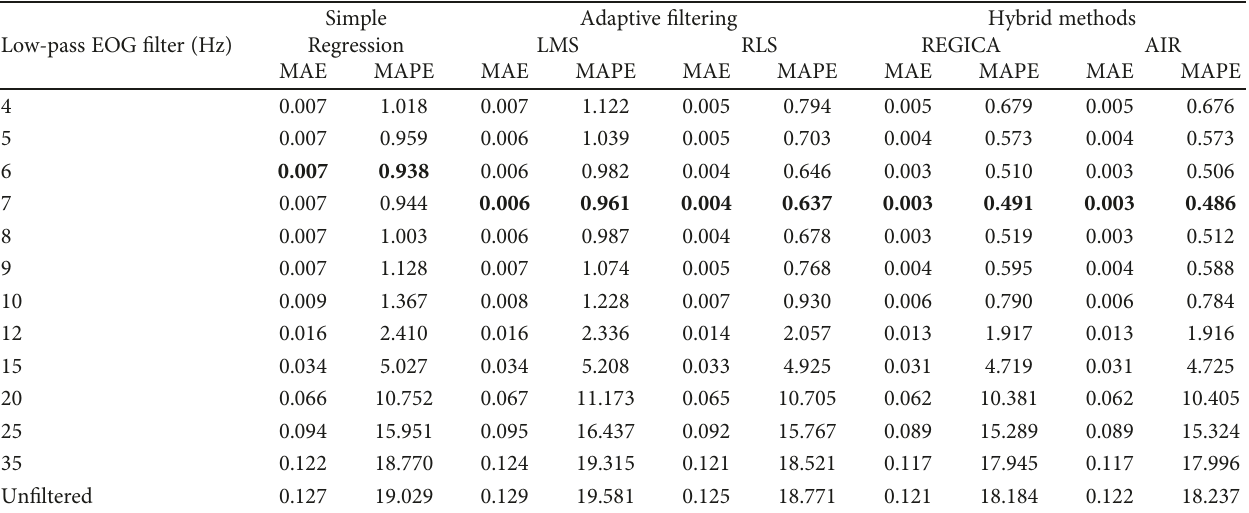
Table 9: Mean absolute error (MAE) and mean absolute percentage error (MAPE) values in beta frequency band (mean of all EEG channels and mean of all simulated subjects).